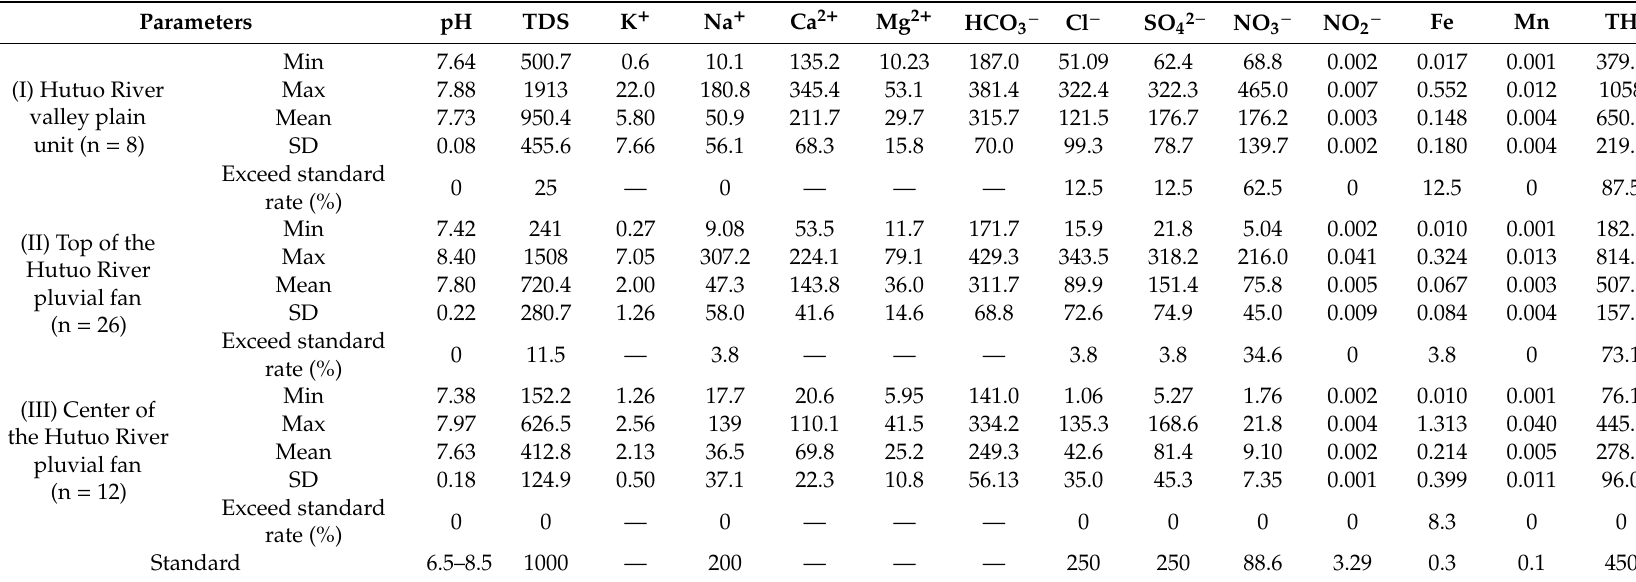
Table 1. Descriptive statistics of groundwater chemical parameters in three hydrogeological units in Hutuo River alluvial-pluvial fan.